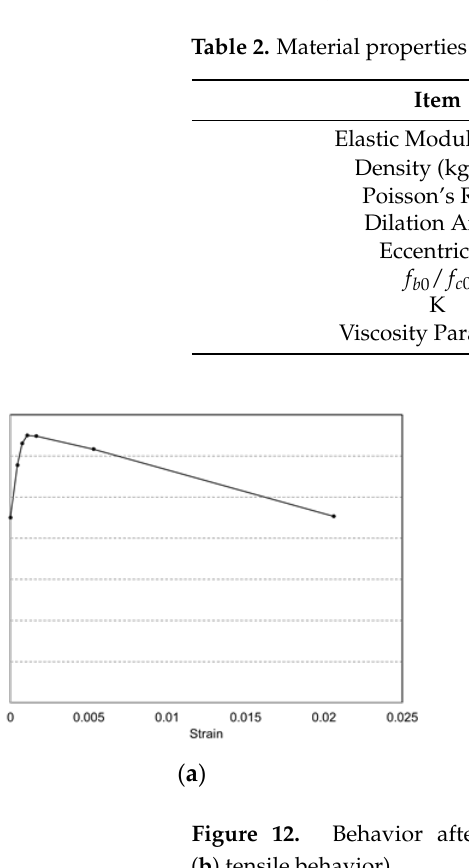
Figure 11. Stress vs. strain for steel plate.